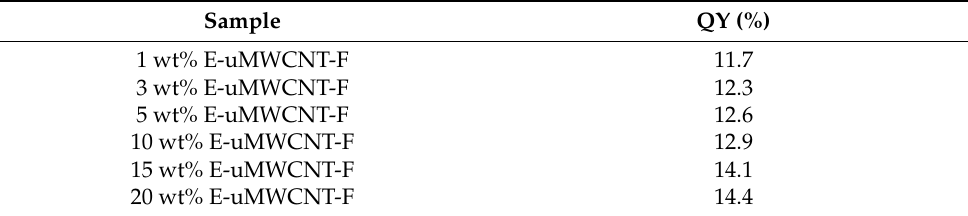
Figure 7. The excitation spectrum ( a ), emission spectrum ( b ), and luminescent decay curve ( c ) of E-uMWCNT-Fs. Table 4. Quantum yield (QY) of E-uMWCNT-Fs with different contents of Eu(TTA) 3 phen.